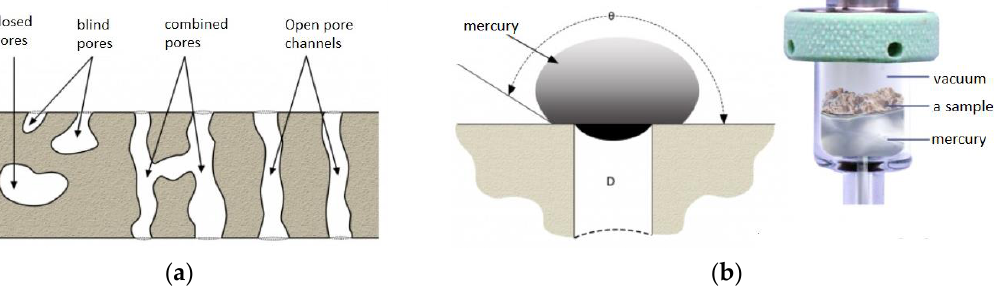
Figure 5. Example of mercury penetration into material; ( a ) a schematic illustration of the types of pores; ( b ) contact of mercury drop with porous material; illustration of mercury saturating a sample in a penetrometer [48].